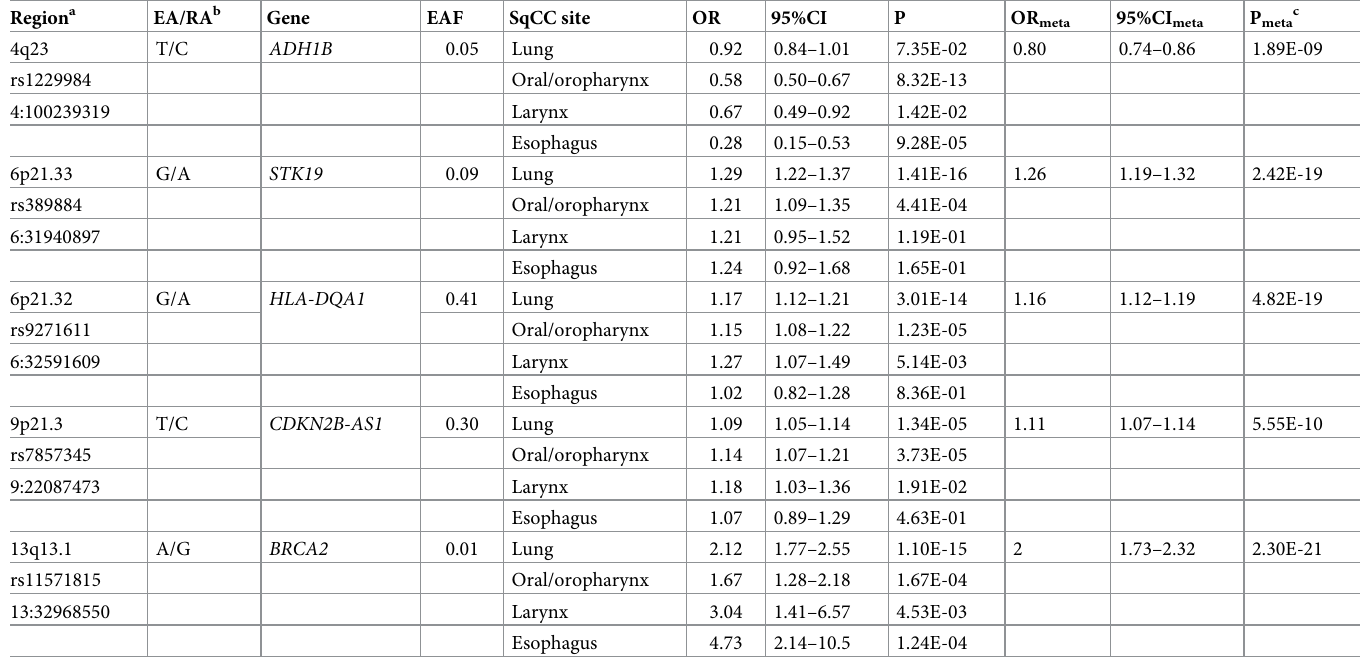
Table 3. Variants within known genomic loci with pleiotropic aerodigestive SqCC associations.